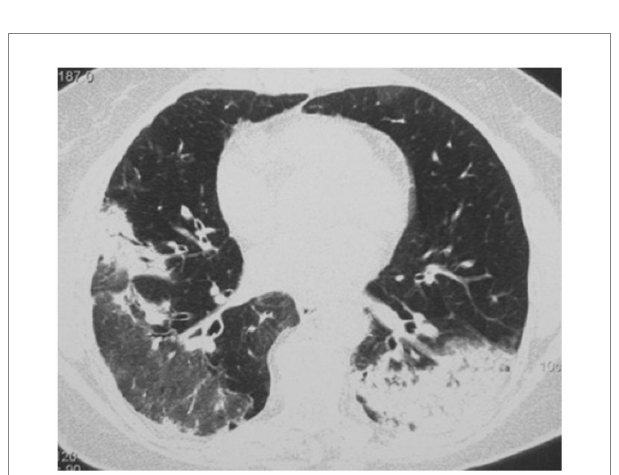
FIGURE 4 High resolution computed tomography scan of a patient with COP. Massive bilateral opacities with presence of air bronchogram and accompanying ground glass opacities on the right lung.